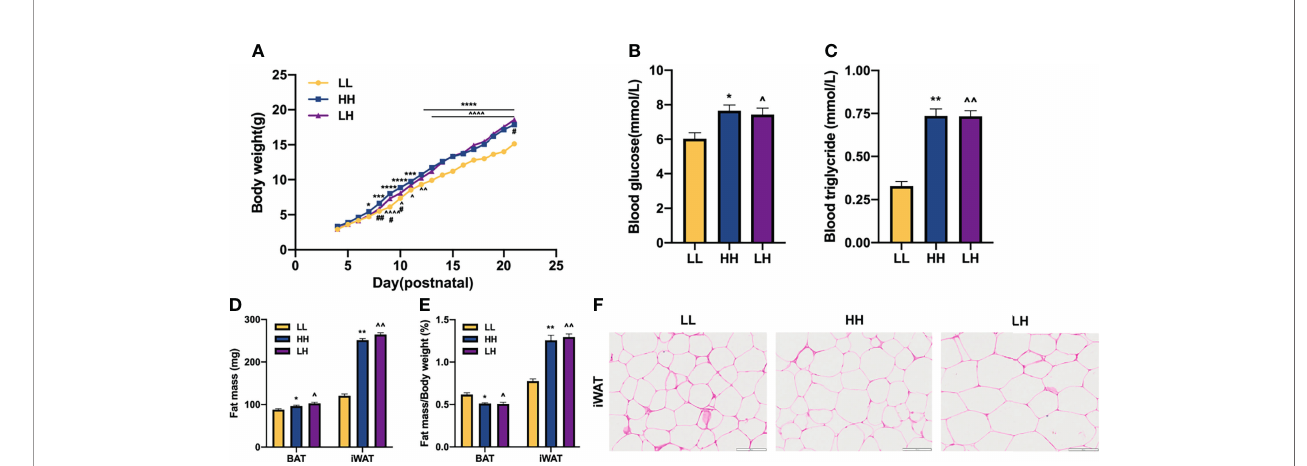
FIGURE 2 | Exposure to maternal HFD both prenatal and early postnatal or early postnatal alone predisposes the offspring for metabolic disorders at P21. (A) Postnatal daily changes in body weight of mice from the LL, HH, and LH group (n = 10, from 5 to 8 litters). Blood glucose (B) , Serum triglyceride (C) of offspring at weaning. (D) Fat tissue weight (BAT, brown adipose tissue; iWAT, inguinal adipose tissue) and (E) ratio of fat tissue to body weight of offspring at weaning (n = 3, from 3 litters). (F) Hematoxylin and eosin-stained iWAT sections of offspring at weaning (n = 3, from 3 litters). Data are expressed as the mean ± SEM. * p < 0.05, ** p < 0.01, *** p < 0.001, **** p < 0.0001: HH versus LL group. ^ p <0.05, ^^ p <0.01, ^^^^ p <0.0001: LH versus LL group. # p < 0.05, ## p < 0.01: LH versus HH group. Scale bar, 100 m m (F)